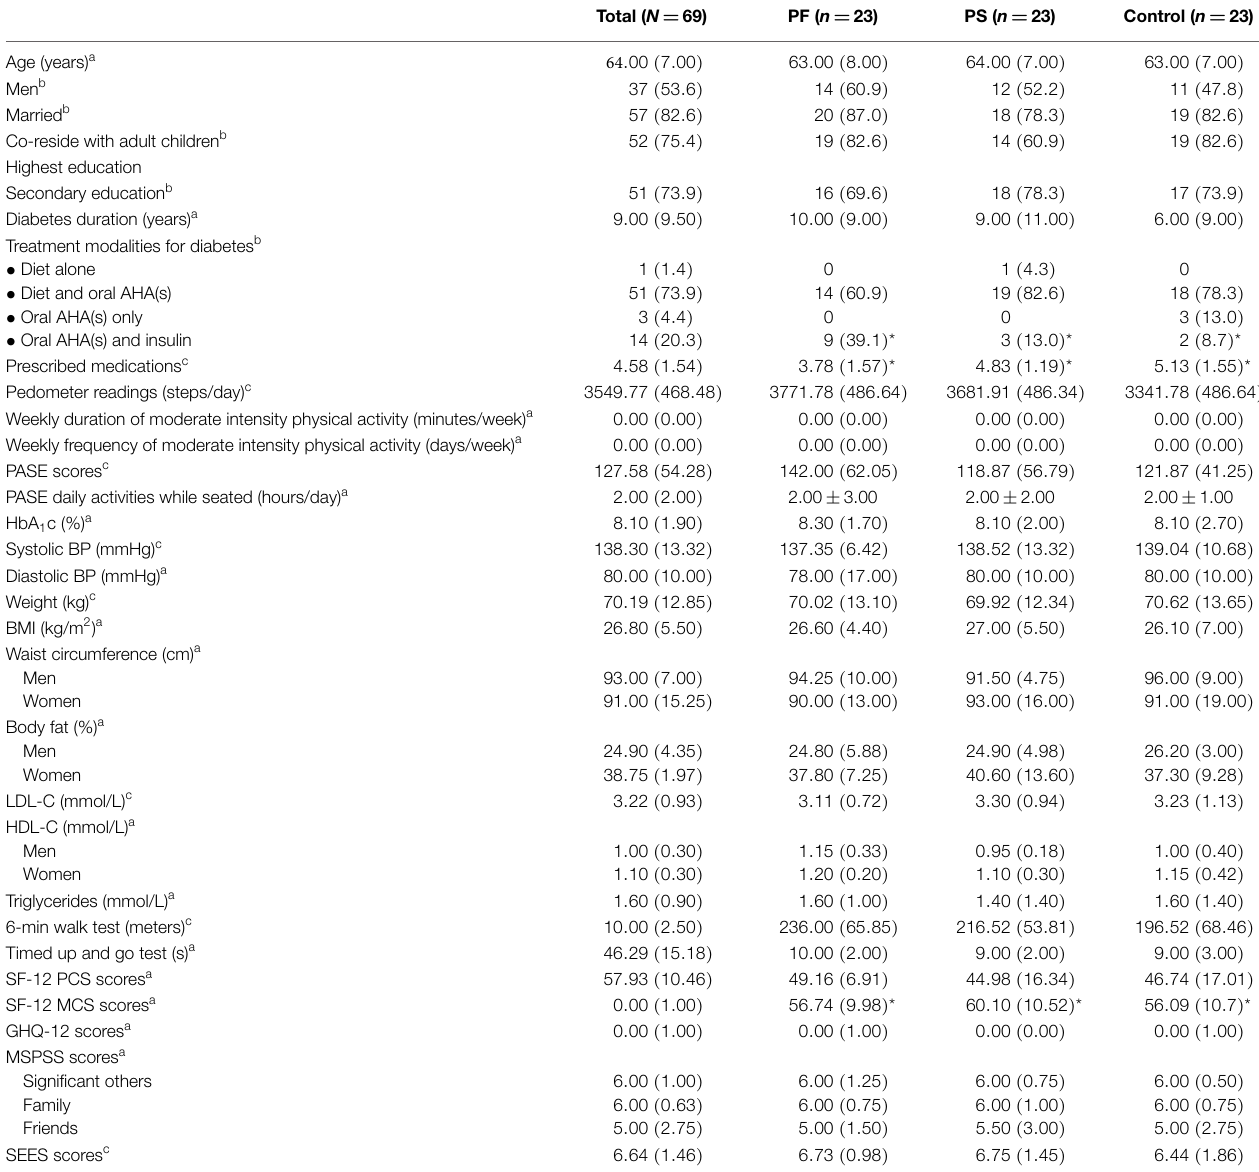
TABLE 2 | Baseline characteristics